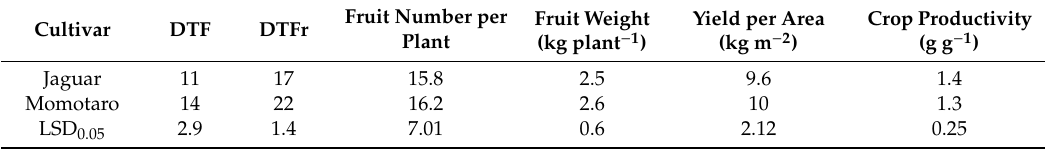
Table 5. Yield components of tomato as a ff ected by LN&HD.